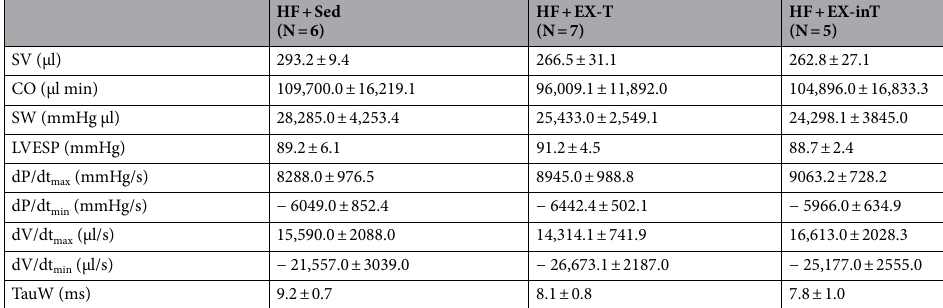
Table 3. Resting cardiac parameters in HF after 6 weeks of exercise training (EX). Values are expressed as mean ± SEM. T: tolerant; inT: intolerant; SV: stroke volume; SW: Stroke work; LVESP: left ventricle end- systolic pressure; dP/dt max : first derivative of maximum intraventricular pressure; dP/dt min : first derivative of minimum intraventricular pressure; dV/dt max : first derivative of maximum intraventricular volume; dV/dt min : first derivative of minimum intraventricular volume; TauW: time constant of relaxation of Weiss. One-way ANOVA, Sidak post hoc analysis.